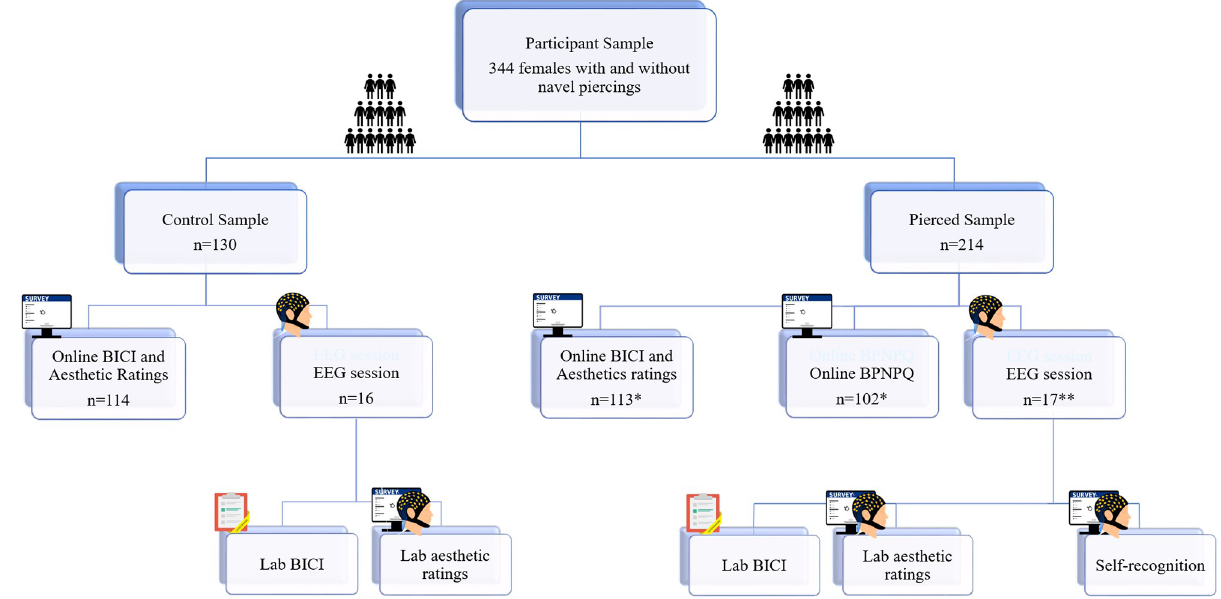
Fig 1. Overview of participant samples and measures. Note that not all participants contributed to all tasks (see also Results). � Of these, n = 18 completed both Online BICI and Aesthetic ratings and Online BPNPQ. �� EEG data was recorded from n = 16 only; one additional participant contributed behavioural responses